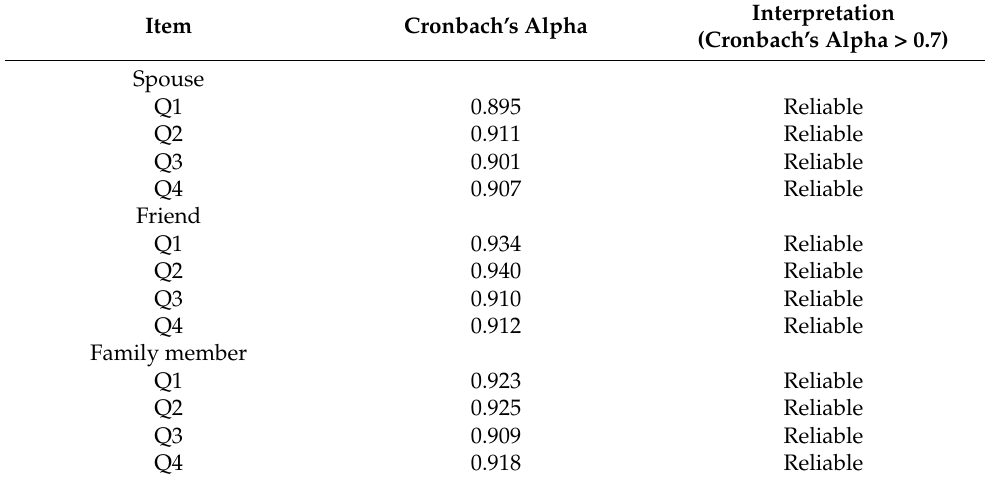
Table 4. NRQ-INA reliability test results (internal consistency reliability) for each item of the